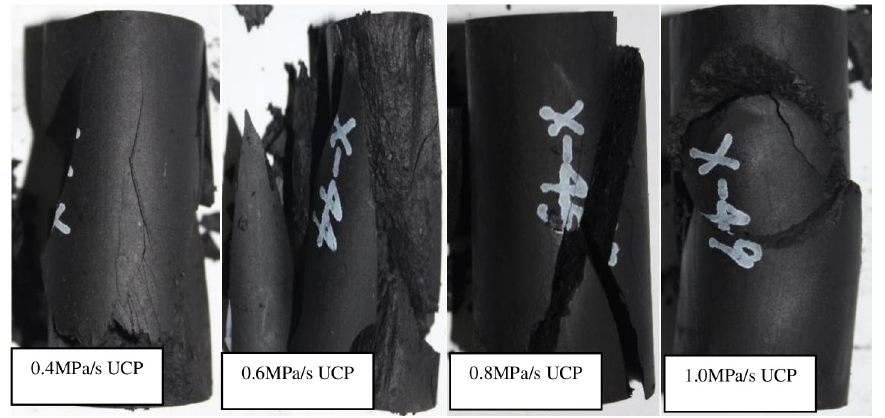
Fig 10. Fractured samples after add axial stress -unloading confining pressure test with axial stress increases under different rates.